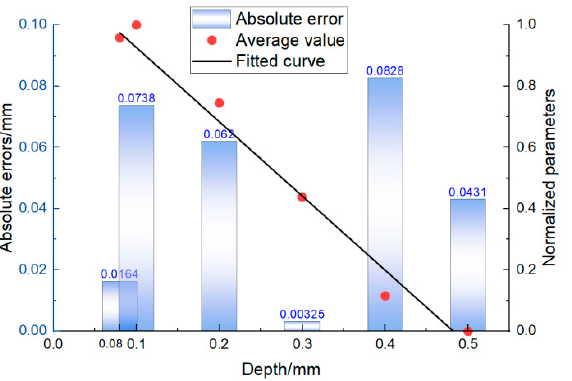
Figure 14. Errors of the fitted equations .